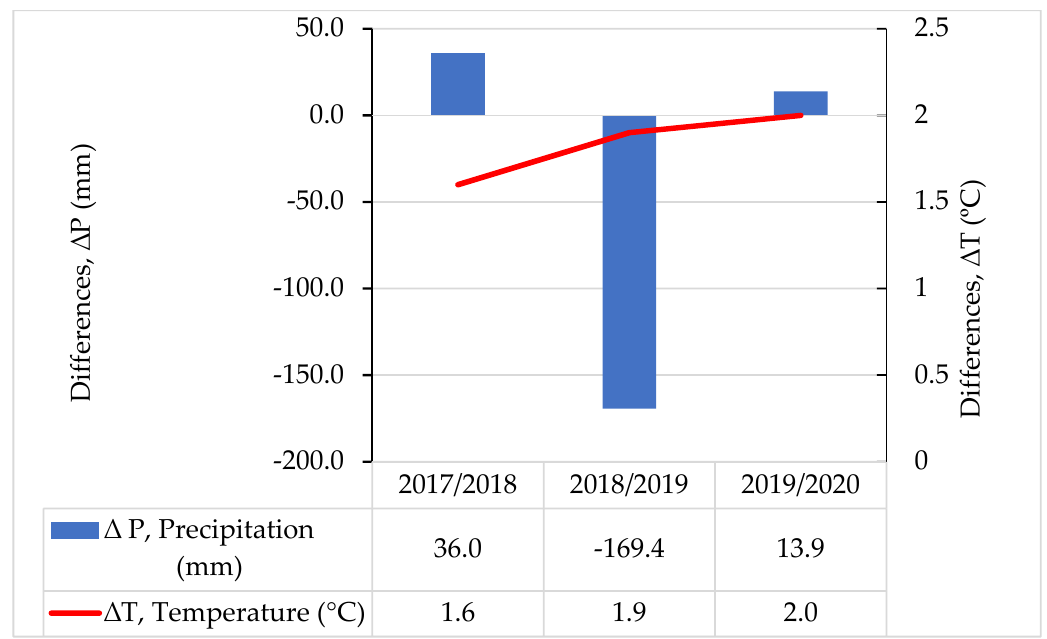
Figure 1. Monthly sums of precipitation (mm) and average air temperatures (°C) and long-term means (1976–2016) at the Grabów Experimental Station.